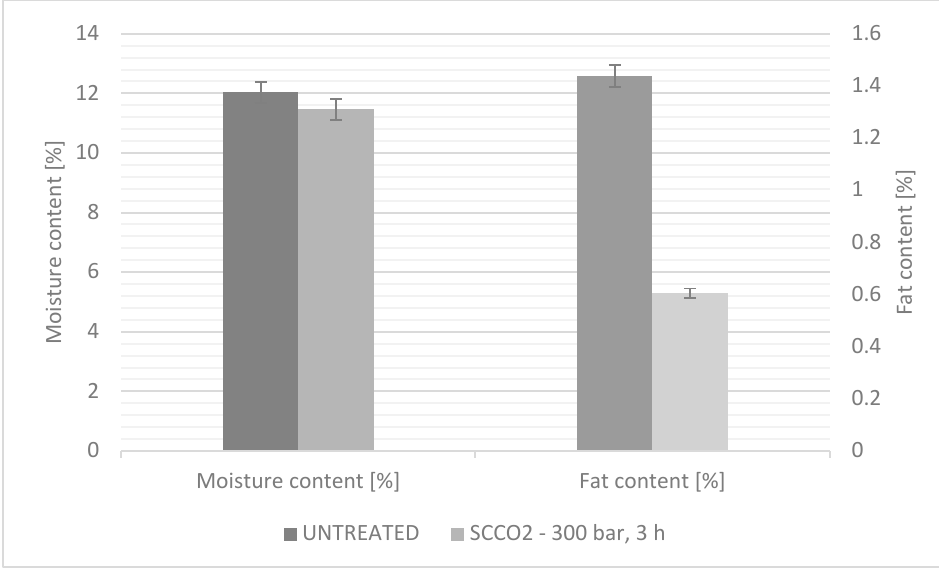
Figure 5. The moisture and fat content [%] comparison of untreated and scCO 2 -treated spelt flour.